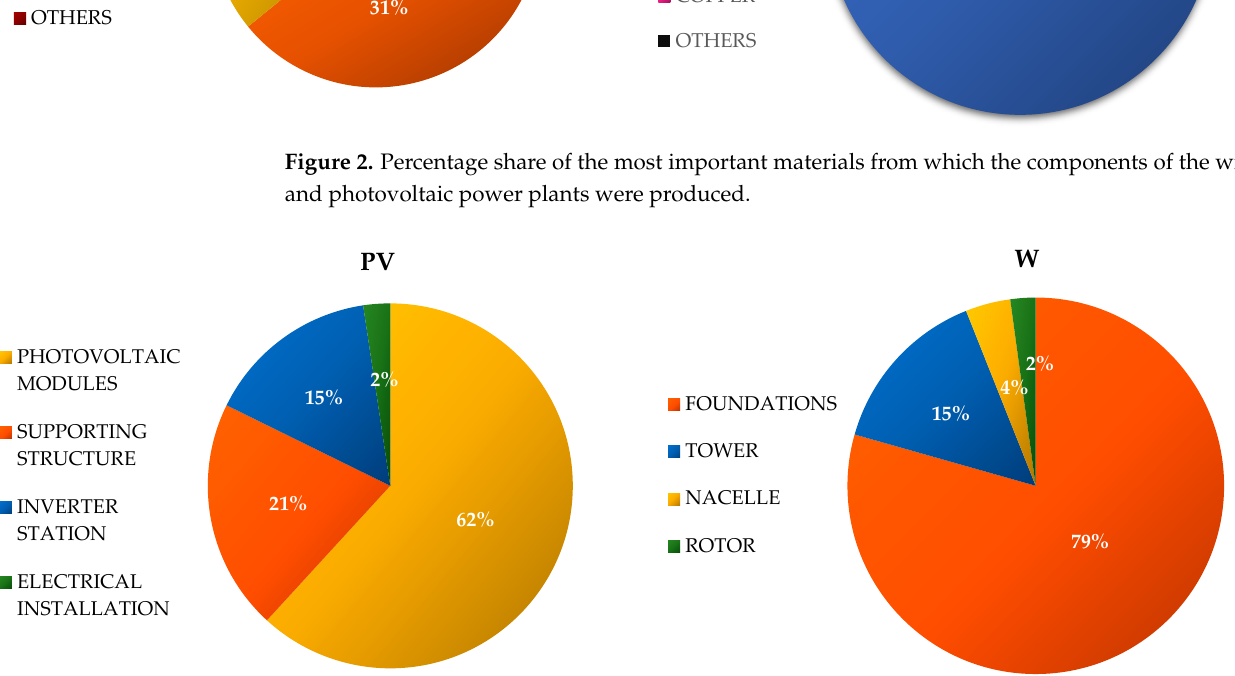
Figure 3. Percentage share of the most important components in the studied wind systems and photovoltaic power plants.